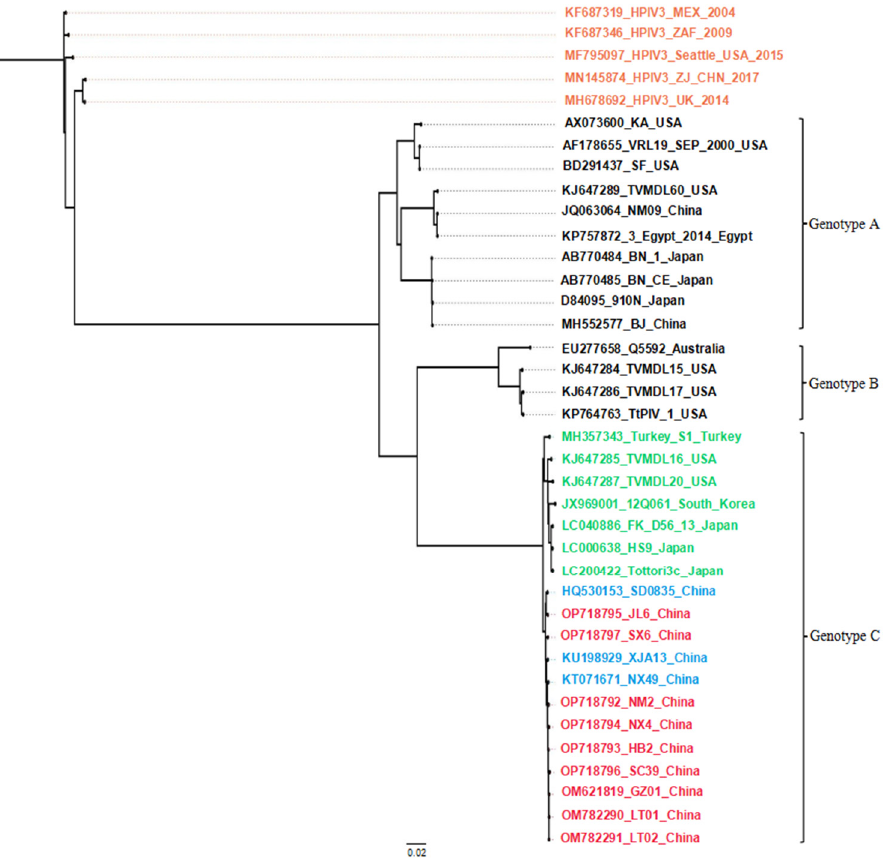
Figure 4. Phylogenetic tree based on complete genomes. A phylogenetic tree was created using the MrBayes software. The orange font represents human parainfluenza virus type 3 sequences; the green font represents overseas BPIV3 genotype C strains; the blue font represents BPIV3 genotype C strains uploaded by others in China; and the red font represents the Chinese strain sequences in this study. Table 3. Nucleotide and amino acid differences between the complete genomes of the Chinese strains in this study and all BPIV3 genotype C overseas strains.